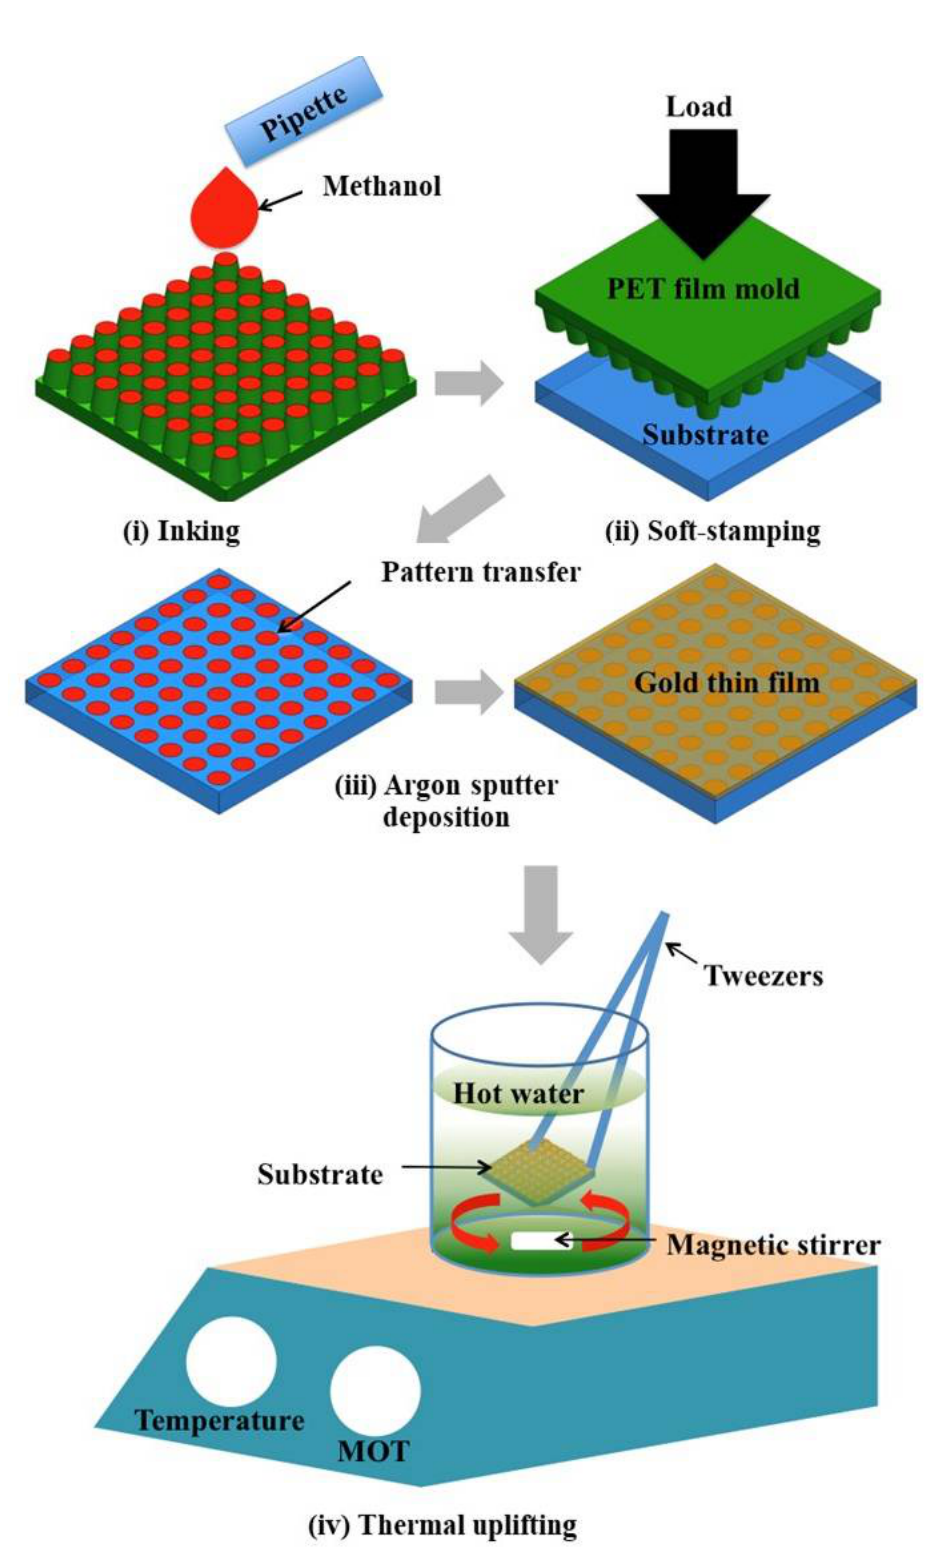
Figure 2. The microfabrication method by soft stamping using a BOPET mold with the thermal uplifting processes.